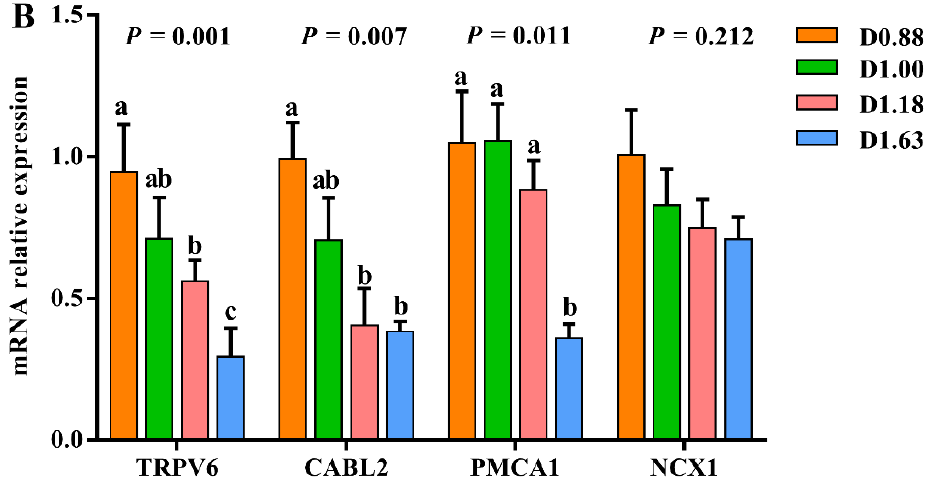
Figure 3. Effects of dietary phosphorus levels on mRNA relative expression of intestinal phosphorus transport-related genes (NaPi-IIb, NaPi-I and VDR) ( A ) and calcium transport-related genes (TRPV6, CABL2, PMCA1 and NCX1) ( B ). Values are listed as mean ± SD ( n = 6). Different letters indicate significant differences ( p < 0.05).